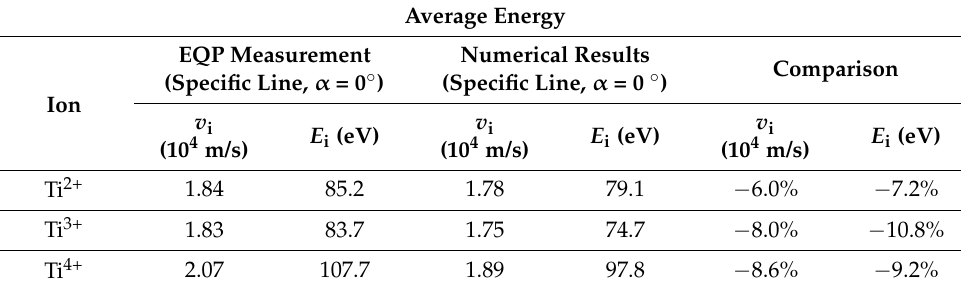
Table 4. Hybrid DSMC/PIC algorithm injection parameters.